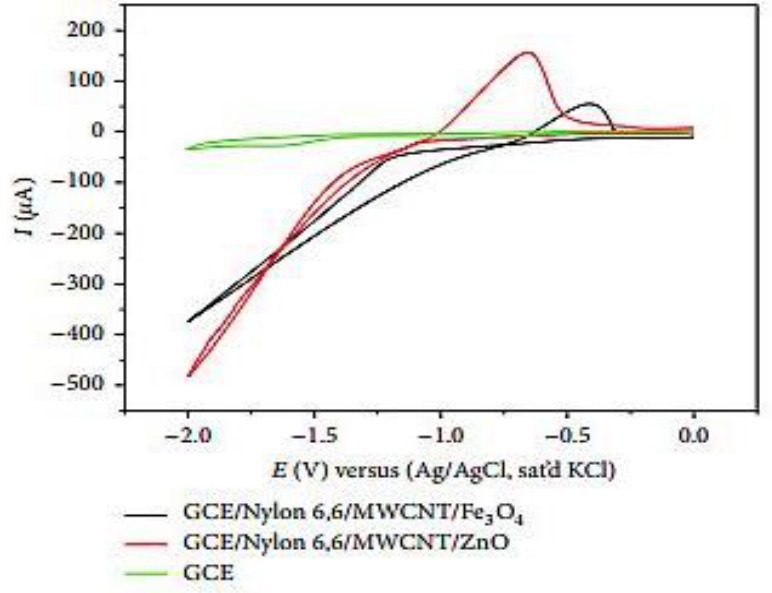
Figure 3. Comparative cyclic voltammograms for GCE, GCE/Nylon 6,6/MWCNT/ZnO, and GCE/Nylon 6,6/MWCNT/Fe 3 O 4 at a scan rate of 50 mVs −1 in 500 μM lindane in 60: 40 methanol/water containing 0.05 M TBAB. Different chemical structures of lindane (α, β, γ, and δ). Reprinted with permission from Hindawi Publishing Corporation, 2018